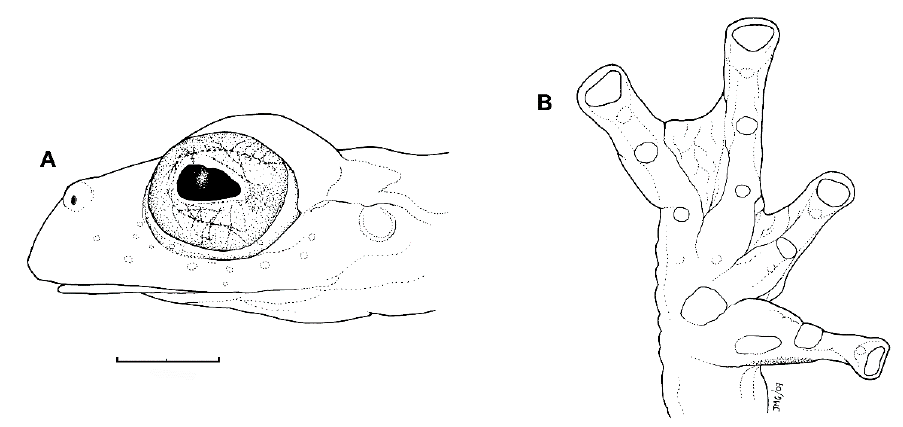
Figure 216. Teratohyla pulverata , QCAZ 32066. ( A ) Head in lateral view. ( B ) Hand in ventral view. Scale bar = 2 mm. Illustrations by Juan M.